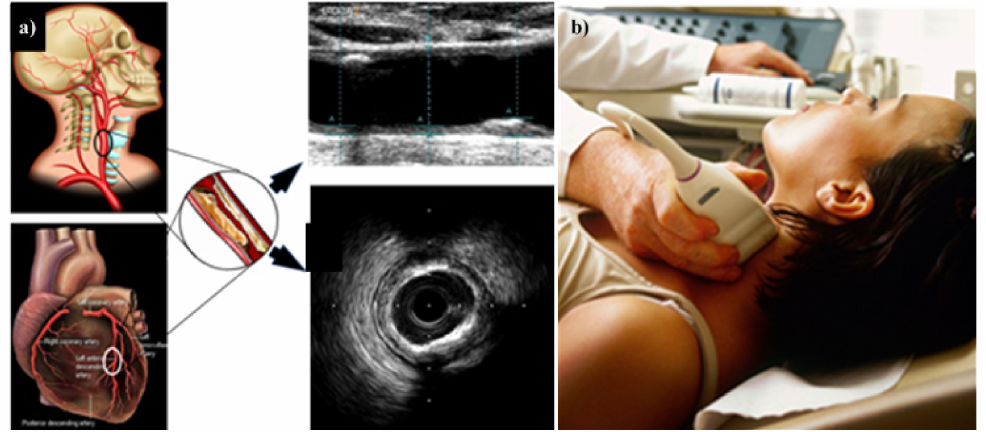
Figure 16. ( a ) Carotid artery disease is being investigated as a potential surrogate marker for coronary artery disease. ( b ) Imaging device where the carotid artery is being scanned with the linear ultrasound probe. The middle panel shows the B-mode carotid longitudinal US scan and IVUS-based artery cross-sectional scan